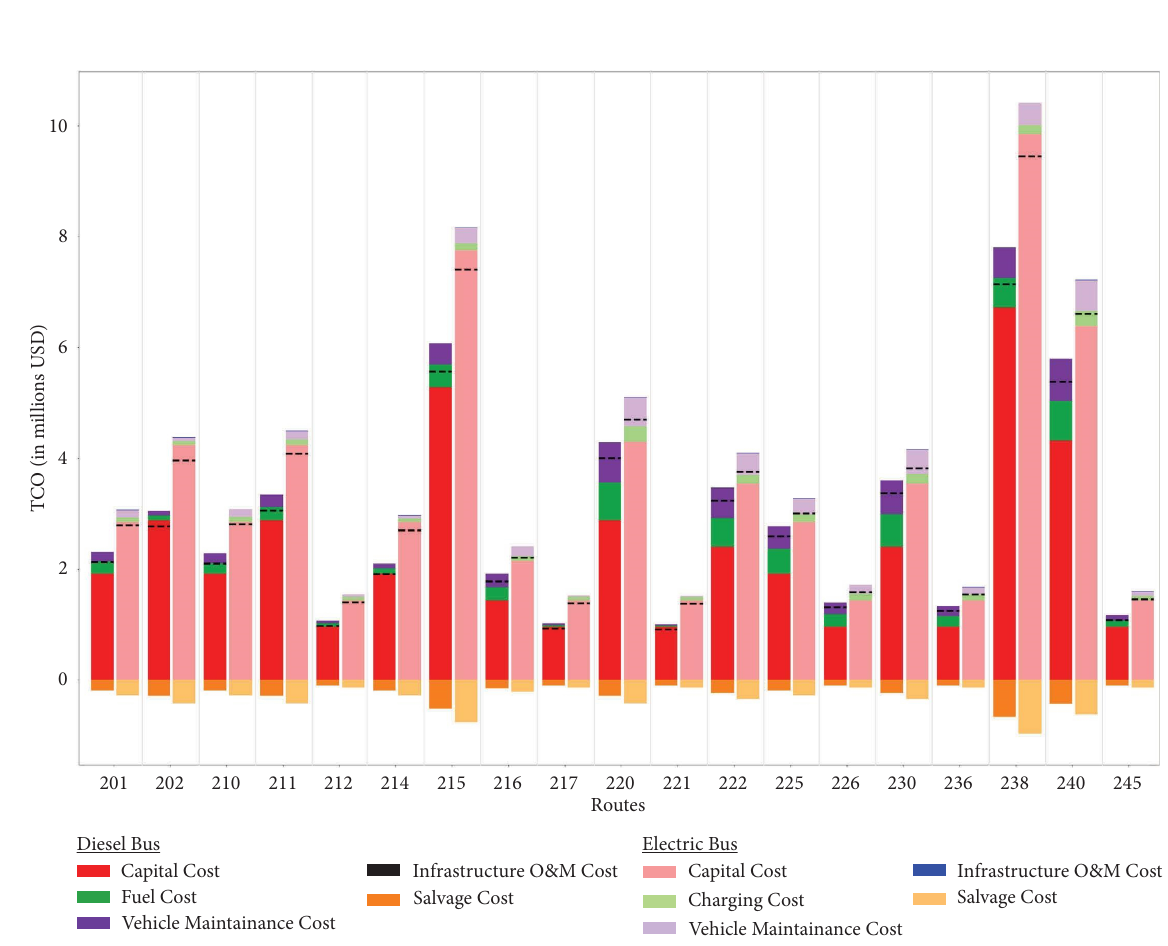
Figure 10: Net present value of the total cost of ownership for